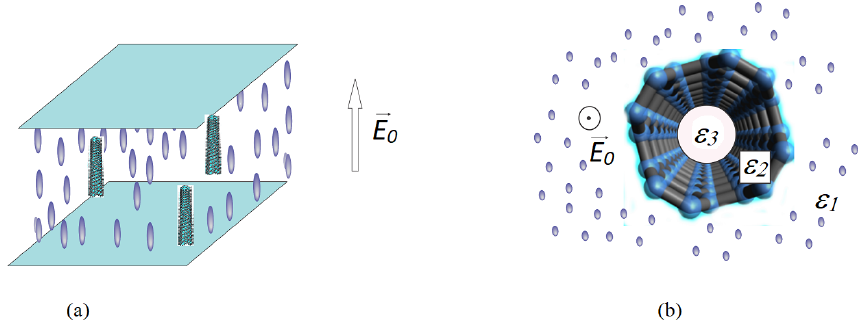
Figure 2. Homeotropic cell containing LC + MWCNT composite. ( a ) the whole cell view, ( b ) in- side